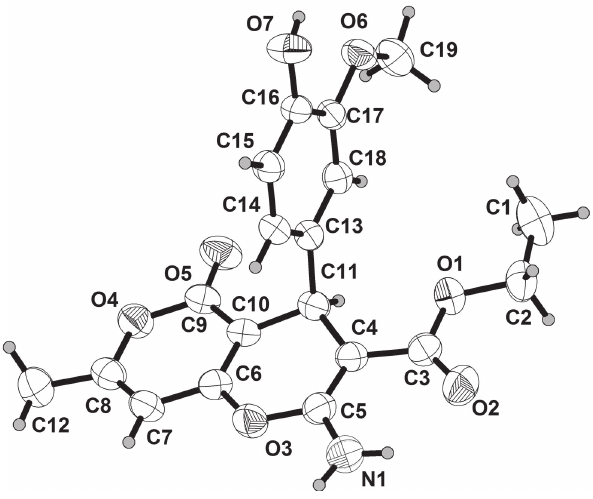
Table 1: Data collection and handling.